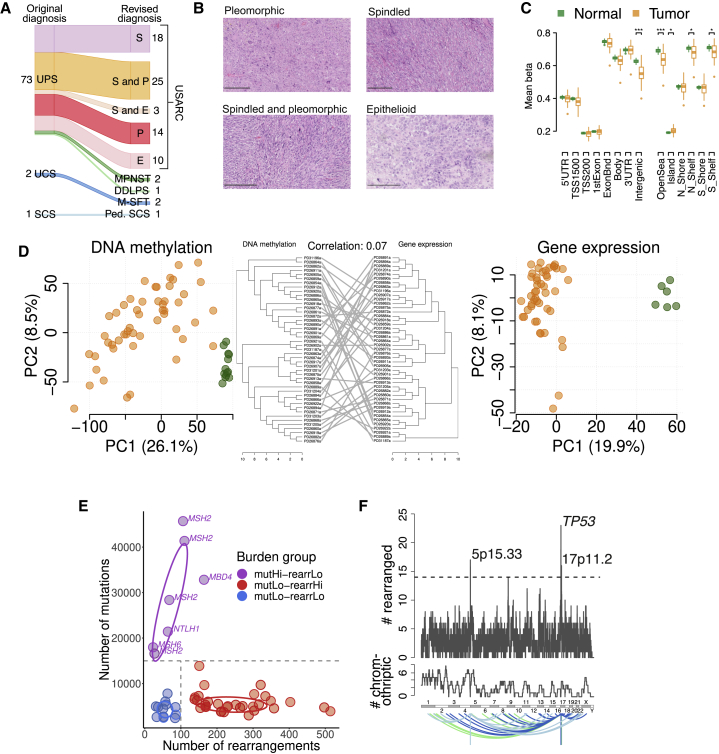
Molecular Classification of USARCs(A) Alluvial diagram showing tumor diagnosis reclassification following expert pathological review. UPS, undifferentiated pleomorphic sarcoma; USARC, undifferentiated sarcoma; UCS, unclassified sarcoma; SCS, spindle cell sarcoma; S, spindle; P, pleomorphic; E, epithelioid; MPNST, malignant peripheral nerve sheath tumor; DDLPS, dedifferentiated liposarcoma; M-SFT, malignant solitary fibrous tumor; Ped. SCS, pediatric spindle cell sarcoma. Numbers indicate the number of samples for each subtype.(B) H&E staining of four representative USARC subtypes. Scale bars, 250 μm.(C) Mean methylation of probes categorized by genomic position (left) or position relative to CpG islands (right), in USARC samples (orange) and normal adjacent tissue (green); ∗q < 0.05, ∗∗q < 0.01, ∗∗∗q < 0.001. Boxes show lower quartile, median and upper quartile; lines denote furthest point within 1.5× the interquartile range away from the box; points denote data further than 1.5× the interquartile range away from the box.(D) Principal-component analysis of tumor (orange) and normal (green) samples for both methylation array data (left) and RNA sequencing data (right) as well as shared hierarchical clustering of RNA and methylation data (center).(E) Scatterplot of rearrangement burden (x axis) against SNV/indel burden (y axis) of USARC samples from WGS. Samples were categorized into three groups: mutation high, rearrangement low (mutHi-rearrLo, purple), mutation low, rearrangement high (mutLo-rearrHi, red), and mutation low, rearrangement low (mutLo-rearrLo, blue). Decision boundary is shown as a dashed line. Filled circles are individual data points, ovals 50% probability intervals.(F) Number of samples that have ≥1 rearrangement in genomic windows of 1 Mb (top), number of samples that have chromothriptic regions overlapping genomic windows of 1 Mb (middle), and rearrangement partners of rearrangements within regions that are significantly enriched (bottom). Regions with significant enrichment (q < 0.2) are labeled.See also Figures S1–S3 and Table S1.